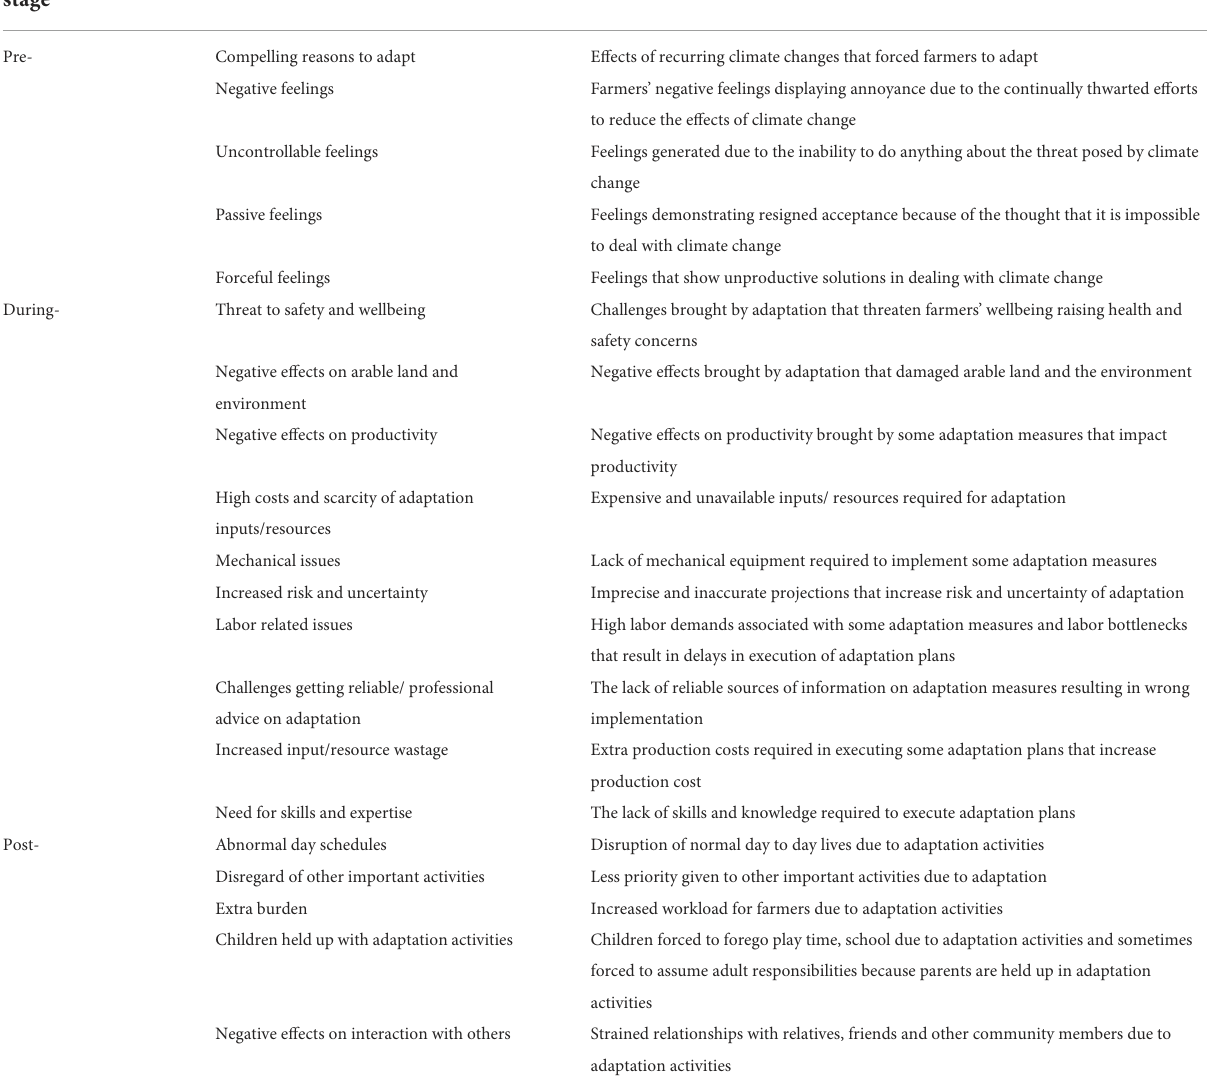
TABLE 1 Key adaptation cost